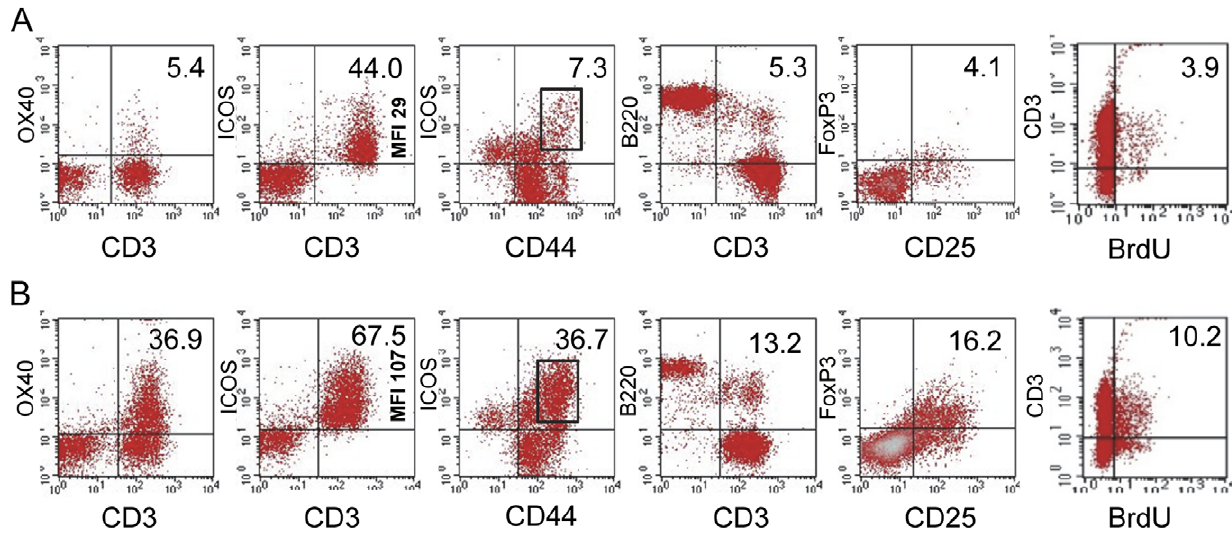
Figure 4. MLN cells in Roquin san/san mice have increased numbers of activated T cells, proliferating cells, and regulatory T cells. MLN lymphocytes from ( A ) normal and ( B ) Roquin san/san mice based on expression of OX40, ICOS, B220, FoxP3, and BrdU incorporation. FoxP3 CD25 expression was determined after gating onto CD4 + cells. Representative data from 2–3 normal and 2–4 Roquin san/san mice.